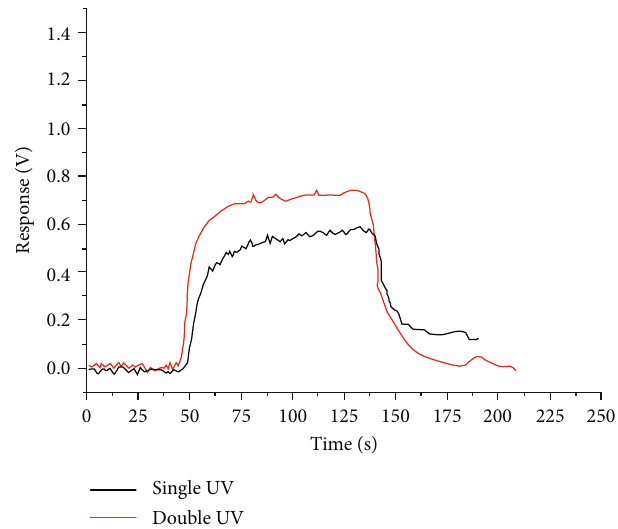
Figure 4: Single lamp-double light sensor response for